Question: According to the figure, is the described quantity increasing or decreasing?
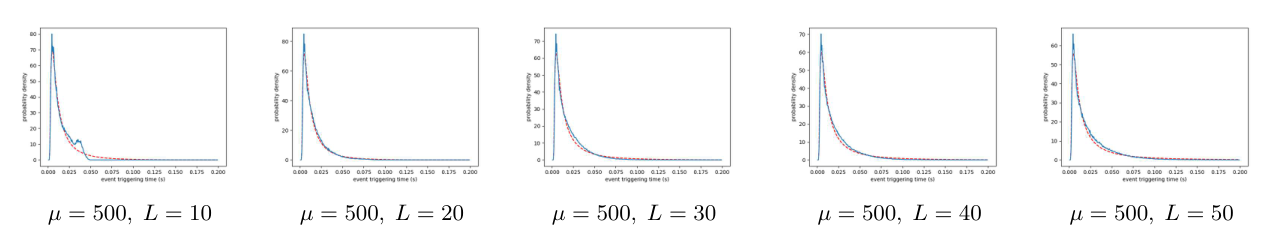
Answer: decreasing